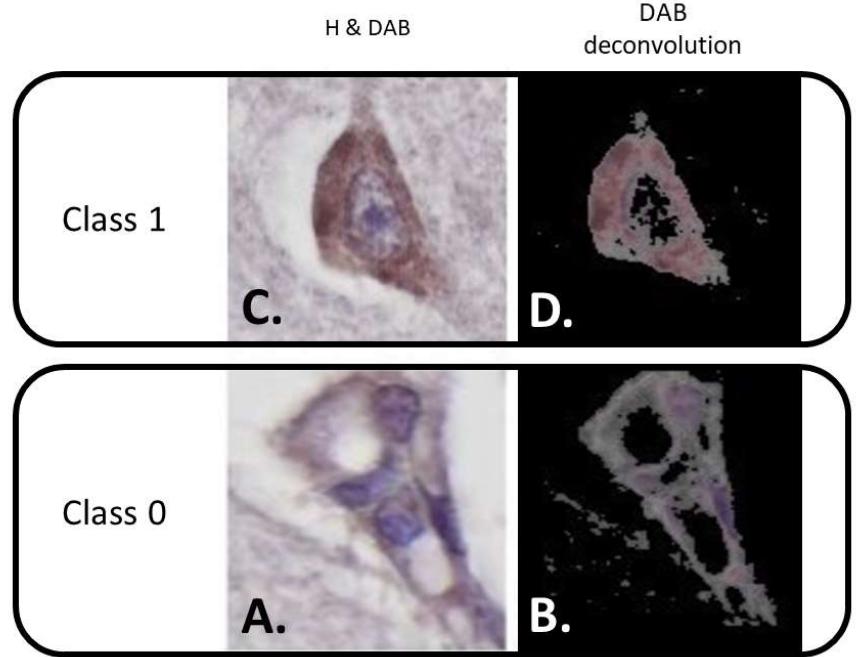
Figure 2. The selection criteria ( A , C ) and the deconvoluted 3,3 (cid:48) -Diaminobenzidine (DAB) chro- mogen ( B , D ). Class 0 represents an example of a misidentified item (vessels which mimic the shape of a neuron). Class 1 depicts an ideal neuron that could be used for the intensity measurements, which has a large amount of cytoplasm and an easily observed nucleus. H = nuclear counterstain; haematoxylin.